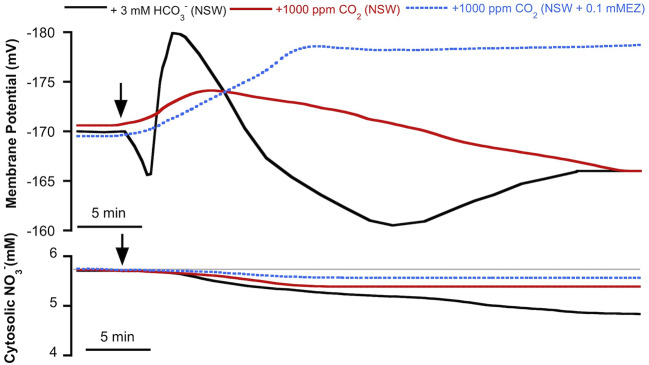
Effect of inorganic carbon increase on the plasma membrane potential (Em, mV) and cytosolic NO3− (mM) measured in Posidonia oceanica mesophyll leaf cells. Arrows indicate the onset of 3 mM HCO3− addition to natural seawater (NSW, black traces, control conditions) and the addition of 1,000 ppm CO2 to NSW (red traces) or to NSW containing 0.1 mM ethoxyzolamide (EZ, dashed blue traces). Traces are representative records of a minimum of four independent experiments using intracellular NO3−-selective microelectrodes. Mean values and statistics are indicated in the text and 
Table 1
. Auxiliary grey line represents the normal cytosolic NO3− concentration before the inorganic carbon additions.